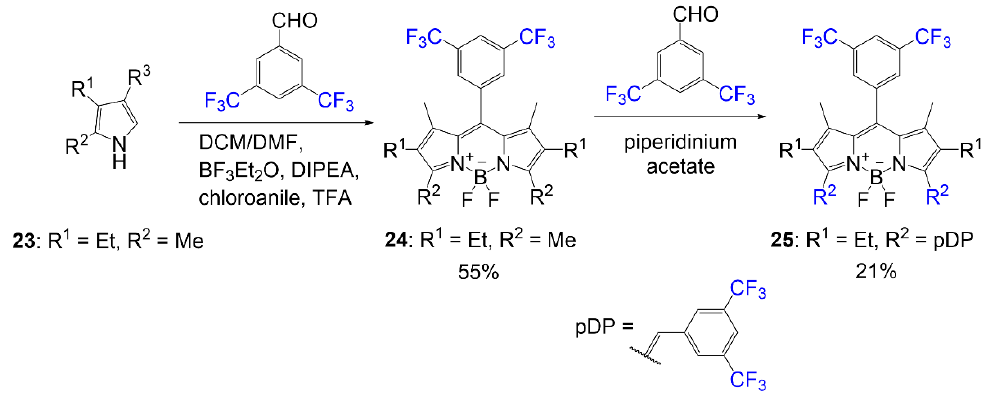
Figure 4. Fluorinated BODIPYs used in 18 FMRI and PET imaging modalities [38,39].